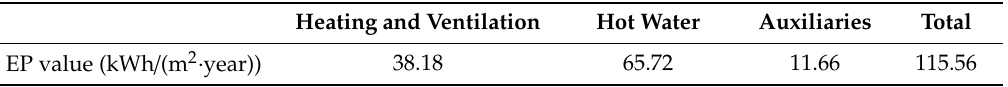
Table 8. The annual primary energy demand EP (kWh / (m 2 · year)) for the multi-family building at Akacjowa Street in Goleniow.